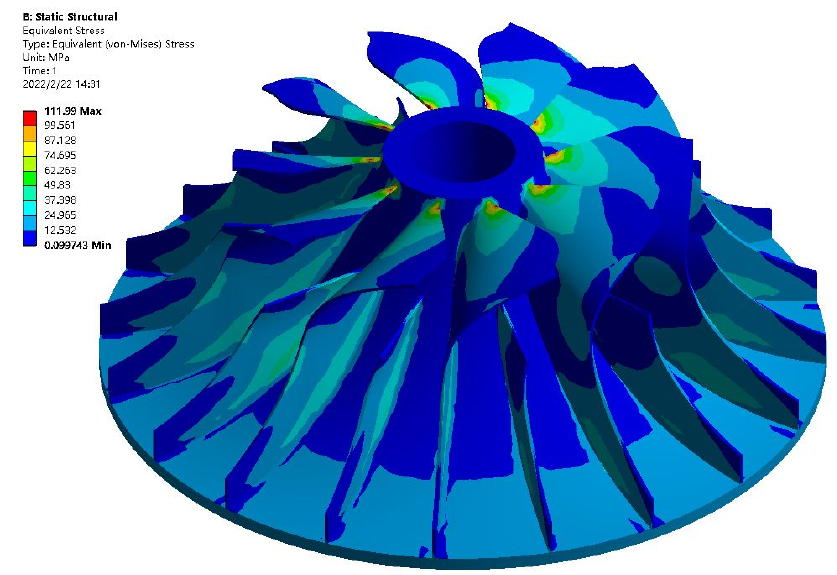
Figure 12. Equivalent stress distribution of Type B.